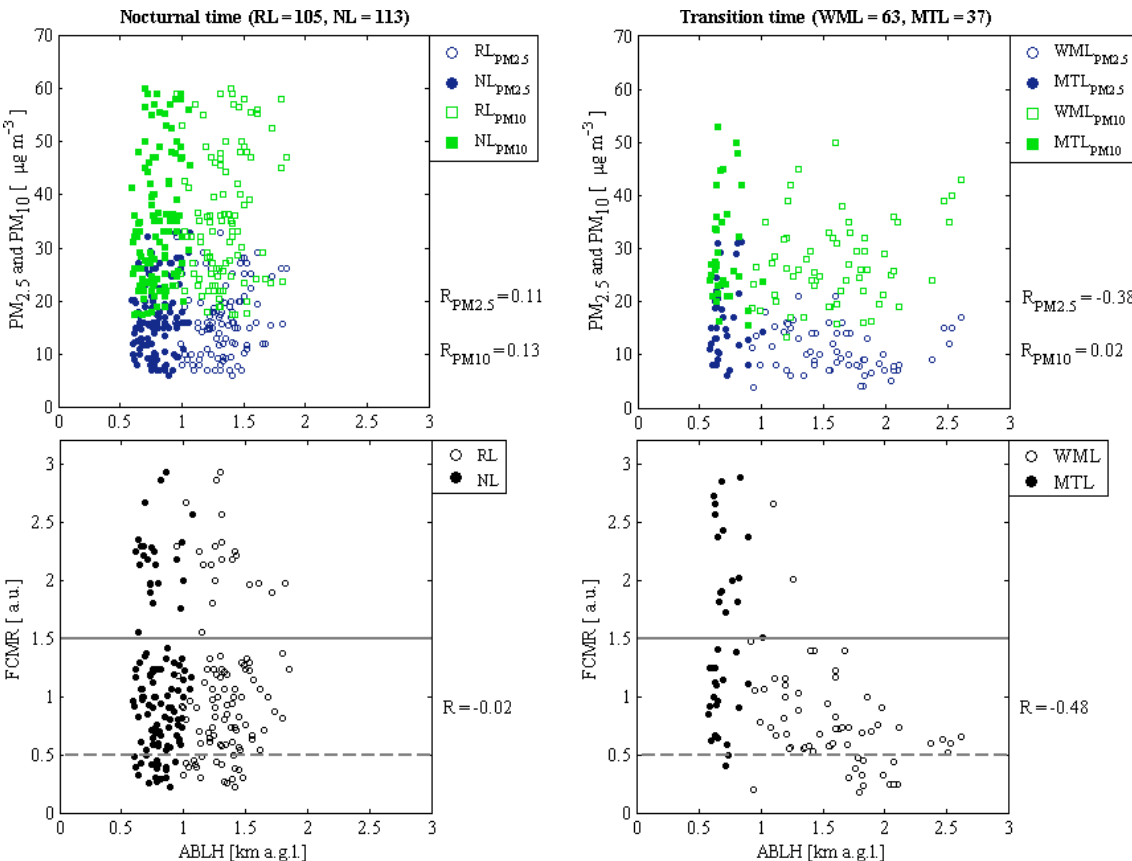
Figure 6. Hourly averages of the surface fine-to-coarse mass ratio (FCMR) and particulate matter (PM 2 . 5 and PM 10 ) measured at the WIOS site in Ursynow, Warsaw, vs. the atmospheric boundary layer height (ABLH) derived from the PollyXT lidar at the EARLINET/ACTRIS site at the RS-Lab, Warsaw, for the July–September period of 2013, 2015, and 2016. Thresholds of the FCMR are marked using horizontal